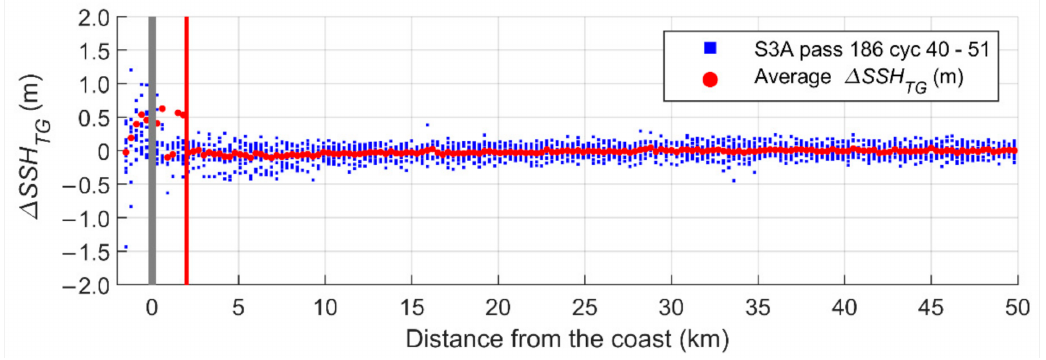
Figure 4. An example of the e ff ect of the coastal zone on Sentinel-3 data. S3A pass 186 cycles 40–51 sea surface height ( SSH SA ) was compared with the geoid-based sea surface height ( SSH TG ), Equation (5), in the Gulf of Riga. The grey and red lines indicate the coast and the distance (2 km) from the coast,